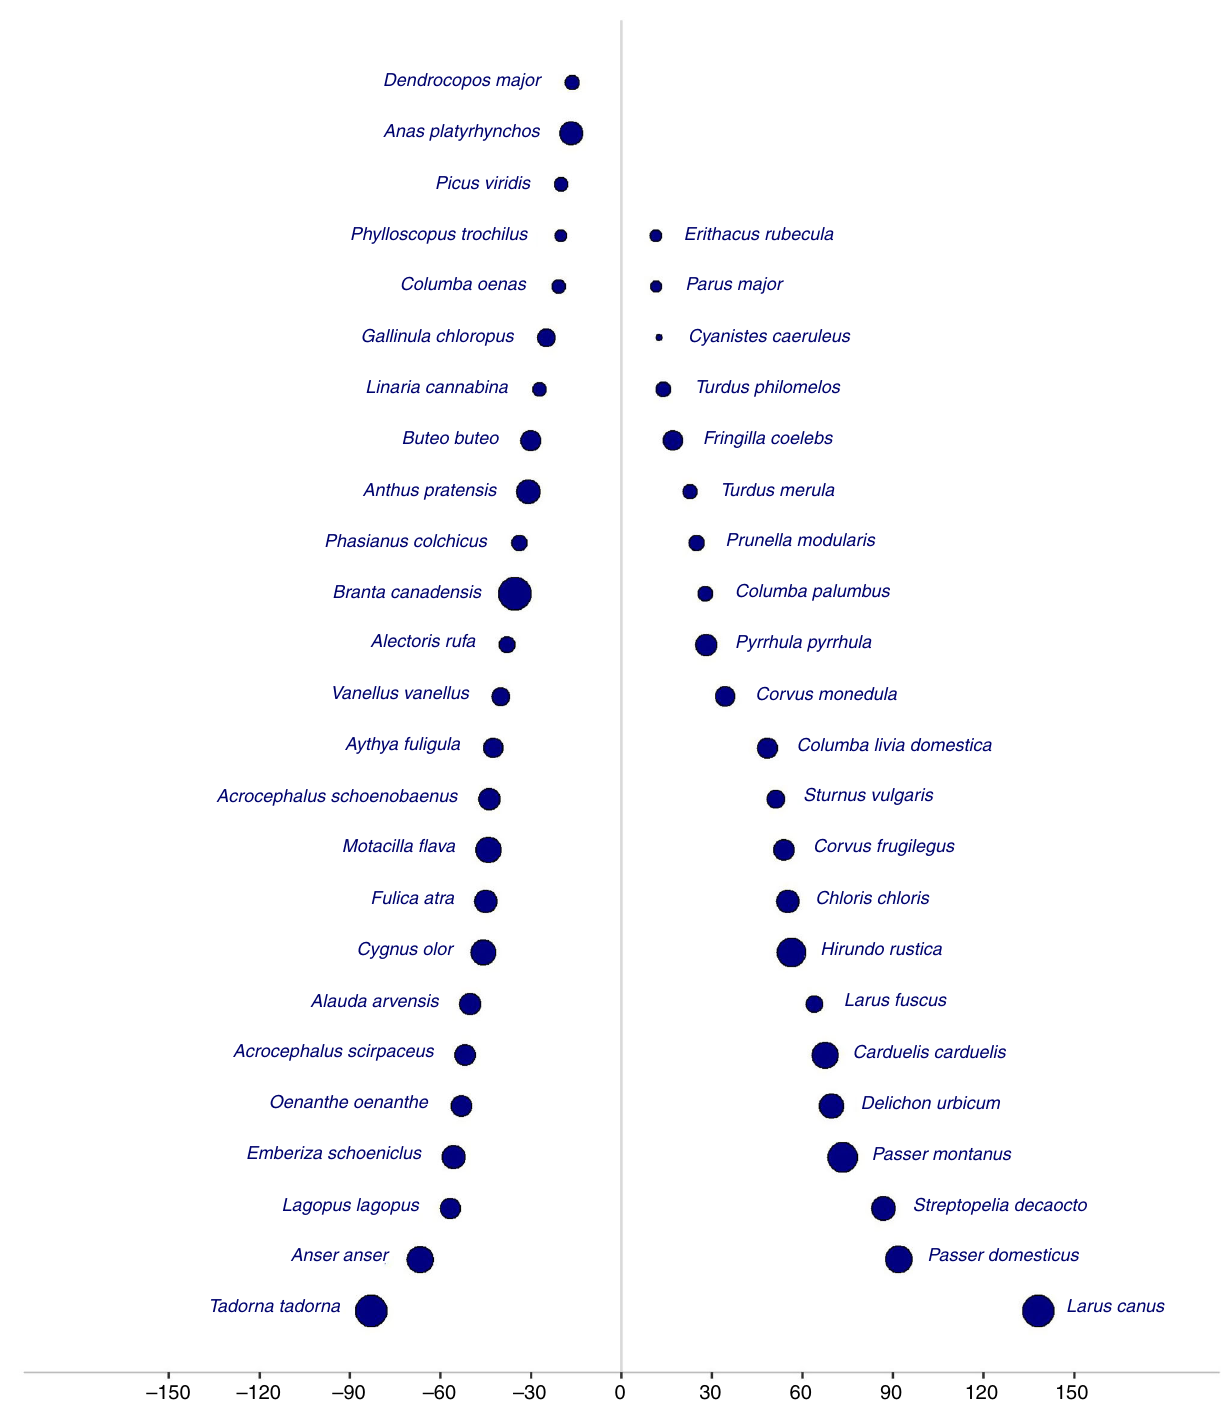
Fig. 2 Abundance changes across the interquartile ranges of road exposure recorded for each species. Only species for which associations between road exposure and abundance were found to be signi fi cant after Bonferroni correction are featured here. The relative effect size of roads (as shown in Fig. 1) is represented by point size. Percentage change in abundance across the interquartile range of road exposure and the relative effect size are not strongly correlated as the former is affected both by the absolute numbers of birds and the range of road exposure present across counts of each lower traf fi c-level roads 27,40,41 . To investigate this, we analysed a subset of 29 species with high sample sizes and signi fi cant asso-